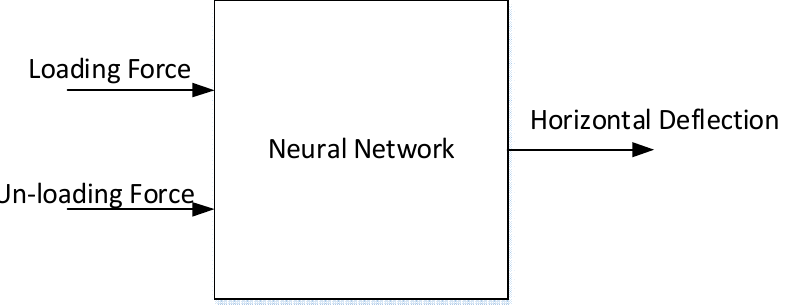
Figure 6. The Proposed model of artificial neural network (ANN) for the force and deflection.